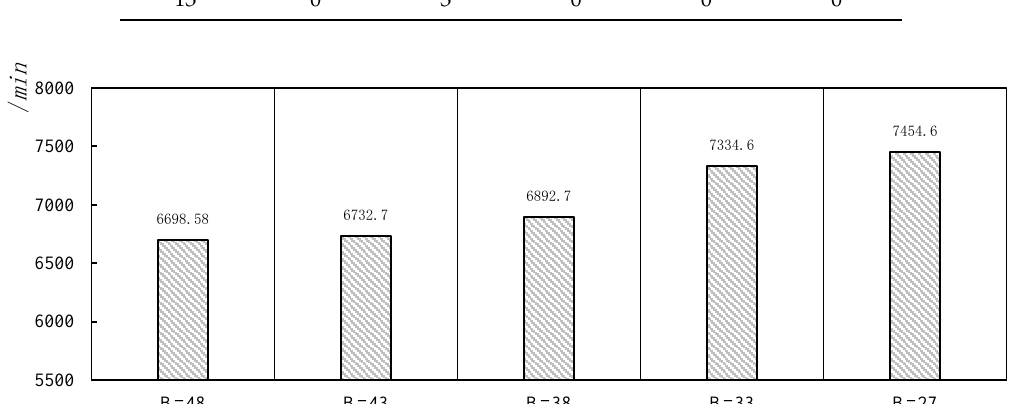
Figure 11. Comparison of the total trip time for various total cost budgets. Table 14. Number of chargers in each node for various total cost budgets.